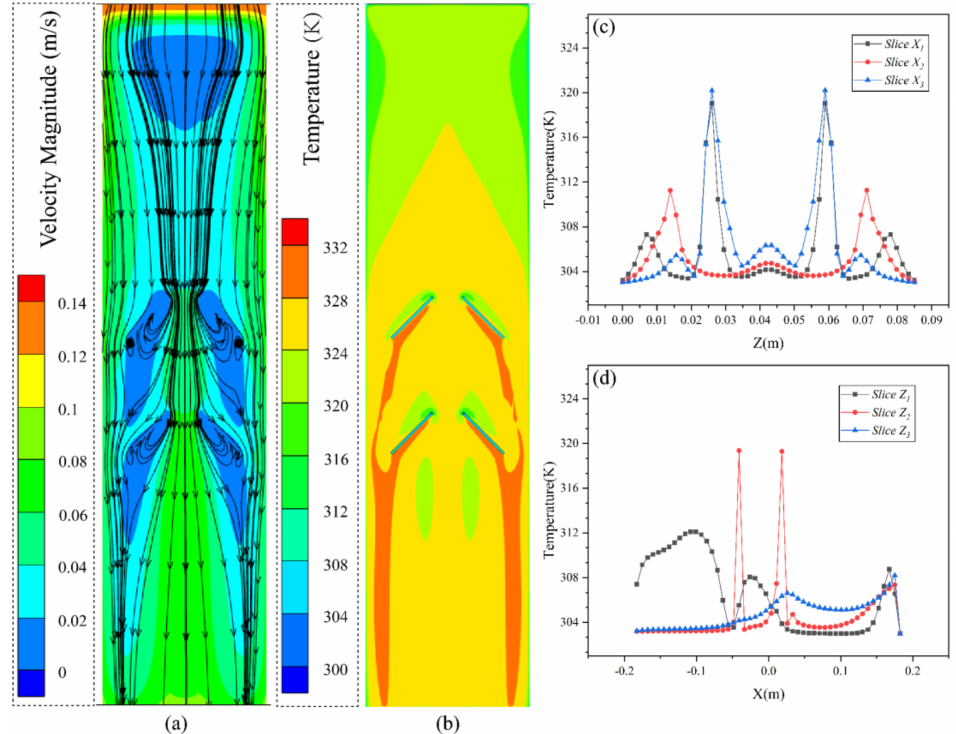
Figure 10. Diagrams of FU- 4 h under steady state conditions: ( a ) streamline diagram, ( b ) temperature contour diagram, ( c ) slice temperature diagram in X direction, ( d ) slice temperature diagram in Z